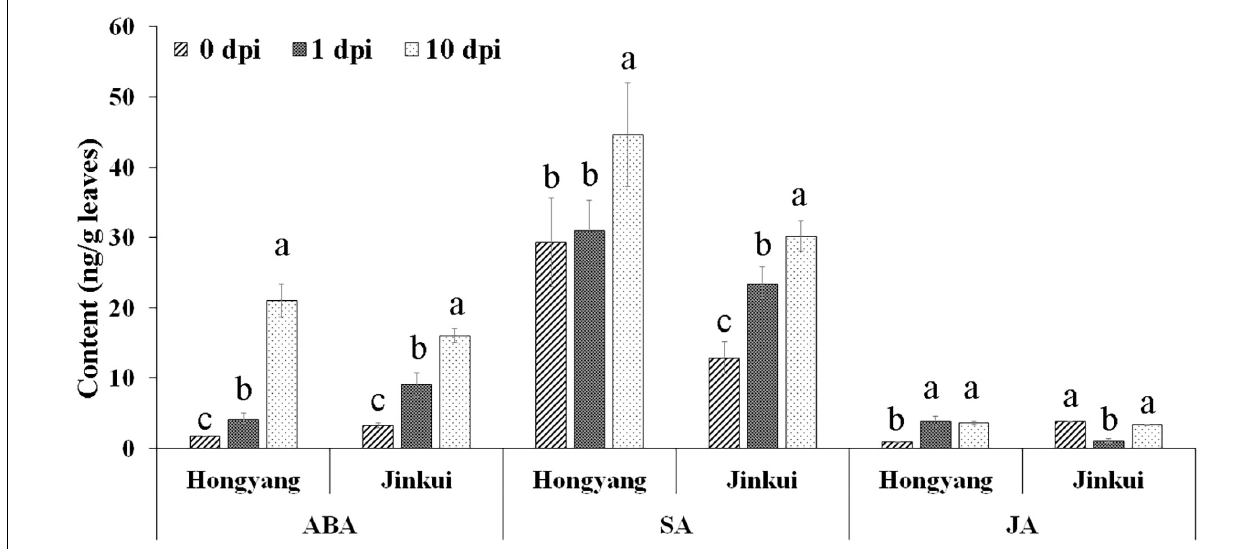
FIGURE 1 | Hormone concentration analysis of abscisic acid (ABA), salicylic acid (SA), and jasmonic acid (JA) at 0, 1, and 10 dpi of Psa in ‘Jinkui’ and ‘Hongyang’ leaves. Values are the means ± SE ( n = 3). Different letters indicate significant differences at a p -value <